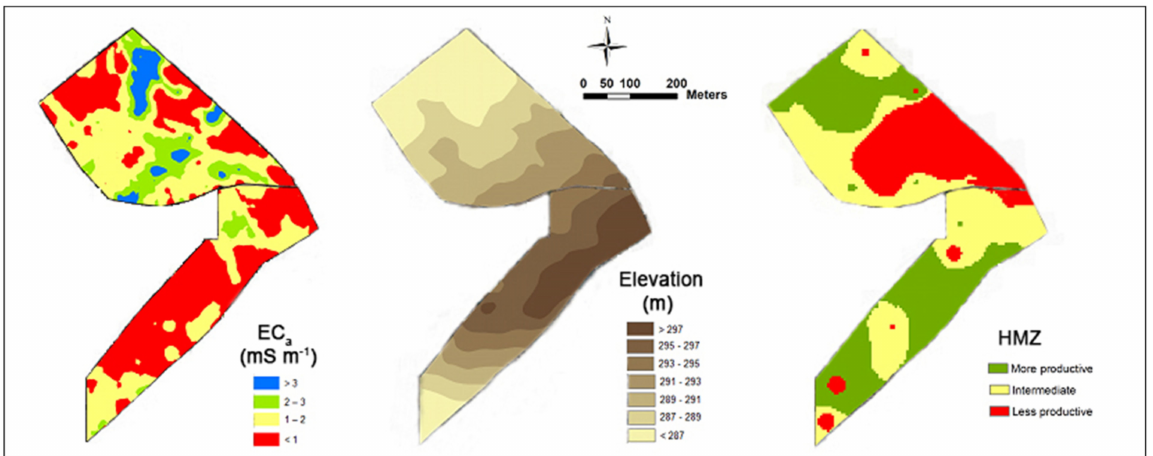
Figure 9. Soil apparent electrical conductivity (EC a ), elevation, and homogeneous management zones (HMZ) of experimental